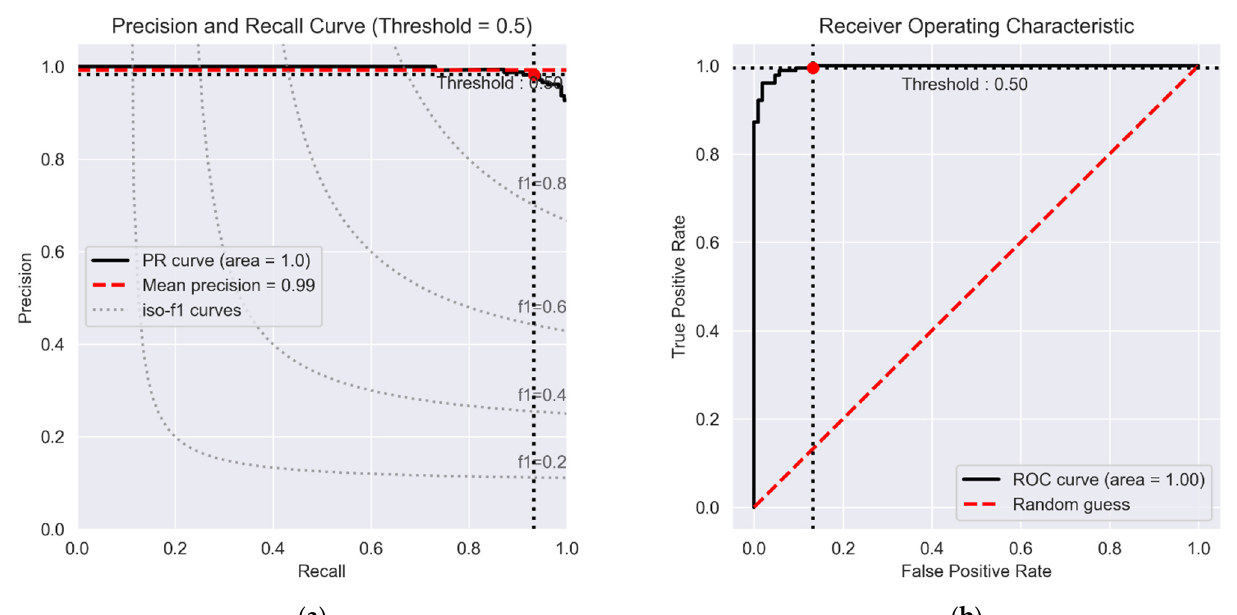
Figure 6. The (a) Precision and Recall Curve and (b) Receiver Operating Characteristic (ROC) of the best performing model .